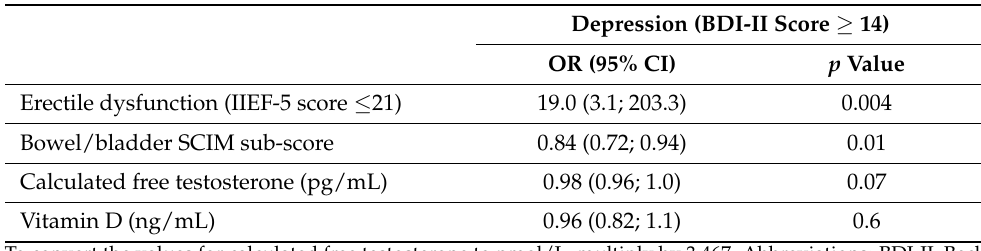
Table 2. Multiple logistic regression analysis of the independent correlates of depression in men with chronic spinal cord injury.